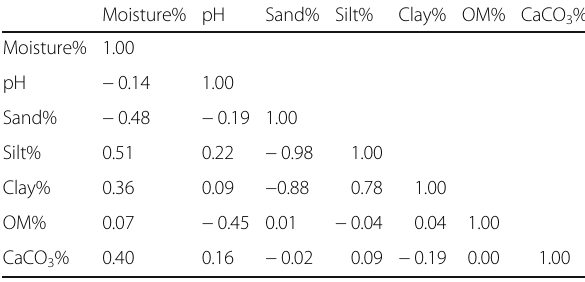
Table 3 Correlation coefficient between the